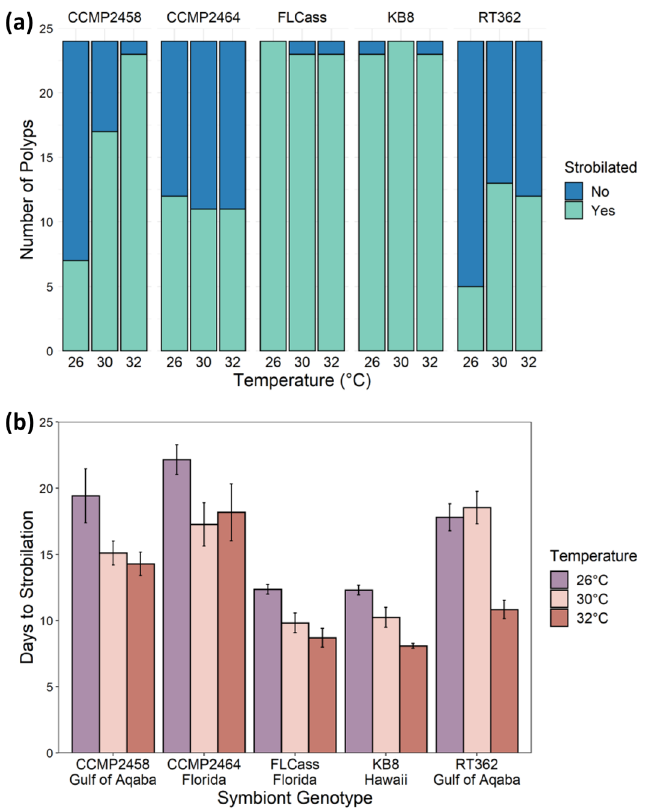
Figure 5. ( a ) Number of polyps infected with one of five algal genotypes that began to strobilate at each temperature by the end of the experiment. ( b ) Mean (+ SE) days that it took for polyps infected with one of five algal genotypes to begin to strobilate at each